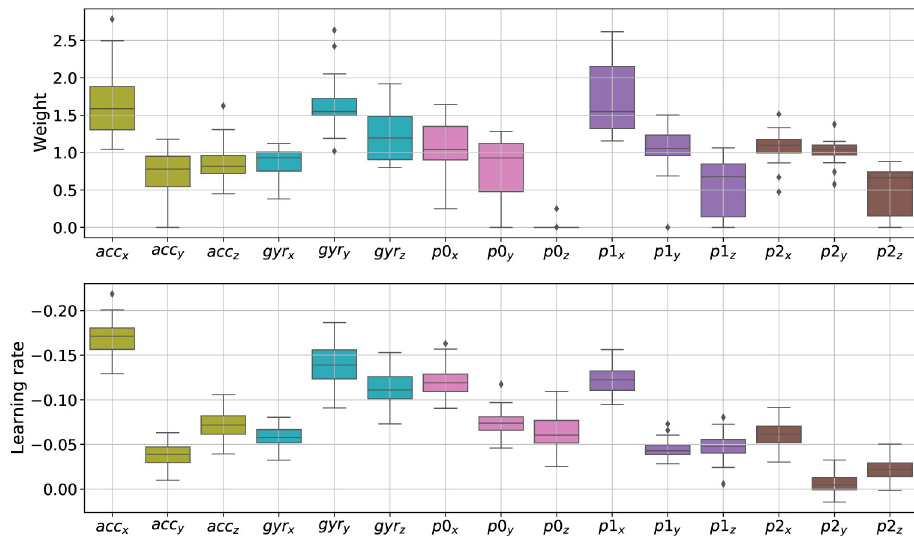
Fig 5. Optimisation weights (top) and learning rate extracted from residual errors (bottom) across all 15 spatial dimensions. Colours are unique per data type (acc, gyr, p0, p1,